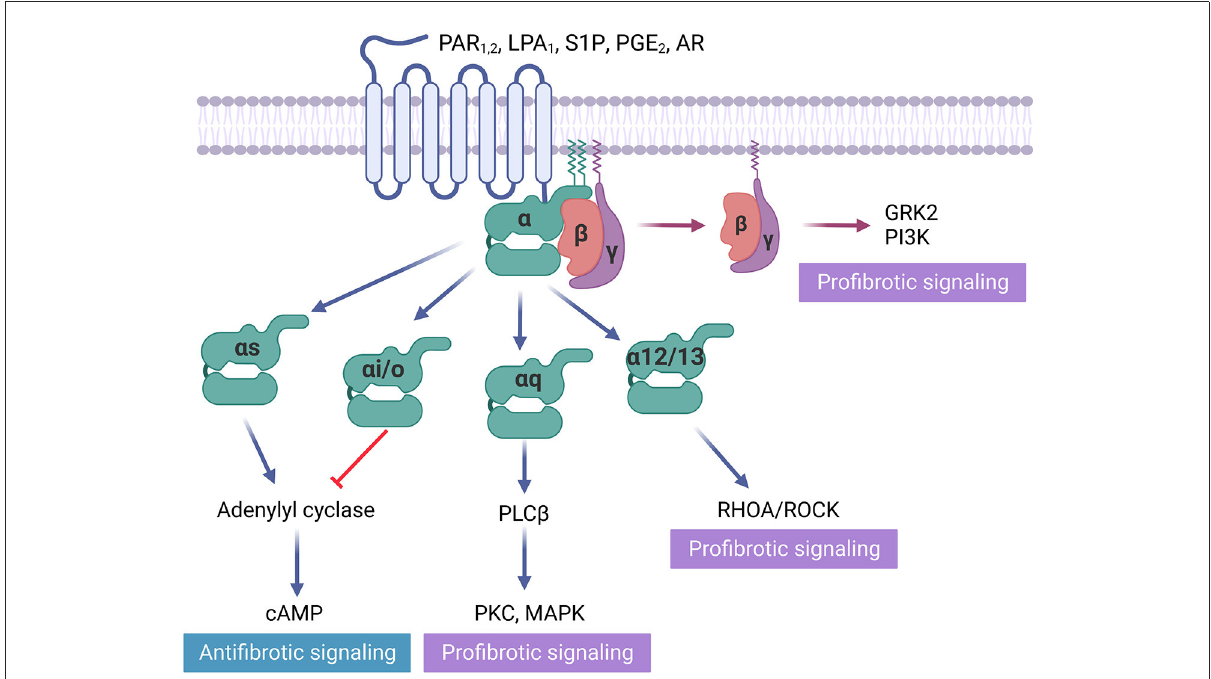
FIGURE1 GPCRs in fibrosis regulation. Some GPCRs mediate profibrotic signals, including protease-activated receptors (PAR1), lysophospholipid receptors (LPA1, S1P), and adenosine receptors (AR), that activate receptors coupled to G α i/o, G α q/11, G α 12/13. G βγ activation is also proved to be profibrotic. In contrast, prostaglandin receptor (PGE2), which activates receptors G α s and direct cAMP activator exert antifibrotic